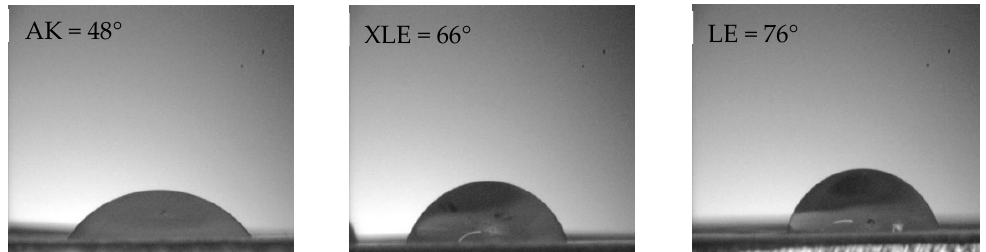
Figure 3. Contact angle of the loose RO membranes used in this study.